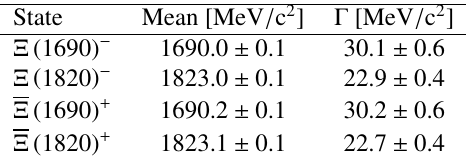
Figure 5. Ratio of the generated and the MC truth partner of the reconstructed Λ K − mass distribution. Adapted from [12]